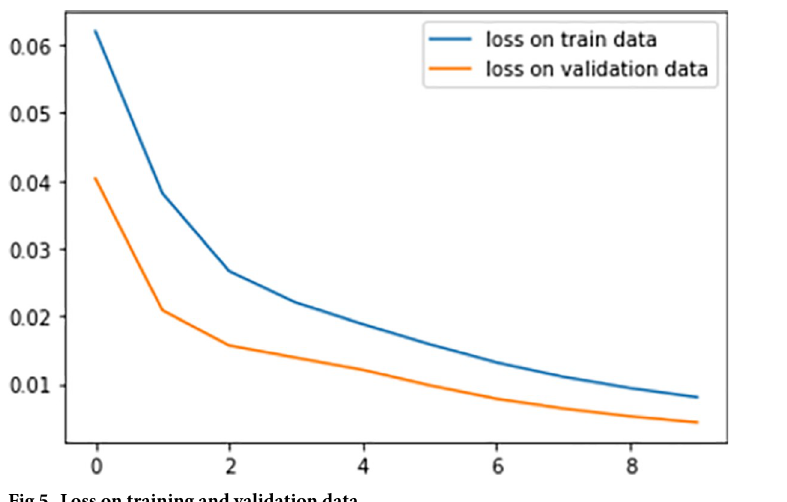
Fig 5. Loss on training and validation